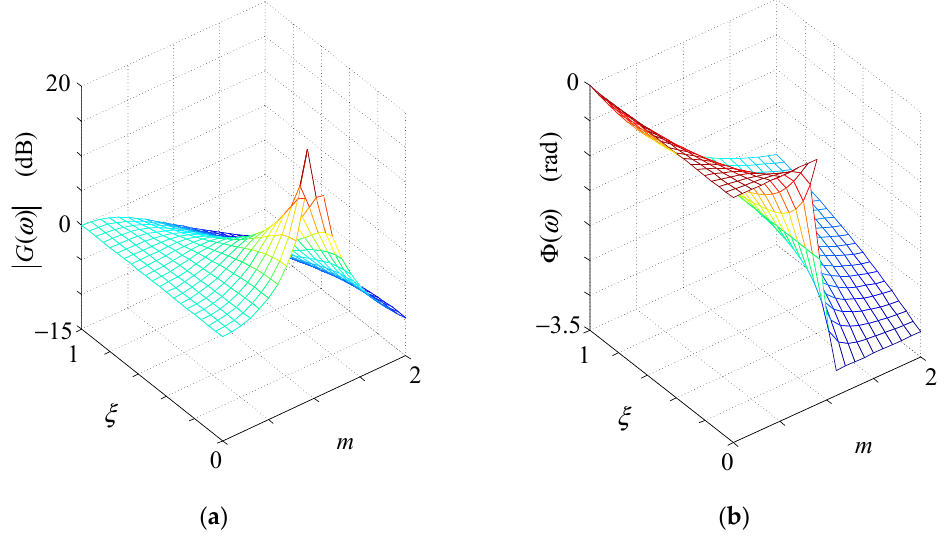
Figure 3. Frequency response characteristics: ( a ) magnitude; ( b )